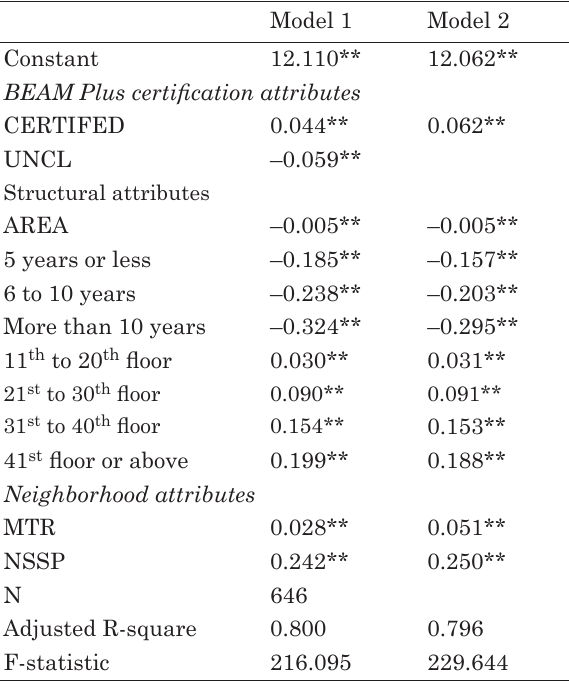
Table 7. The results from the hedonic pricing